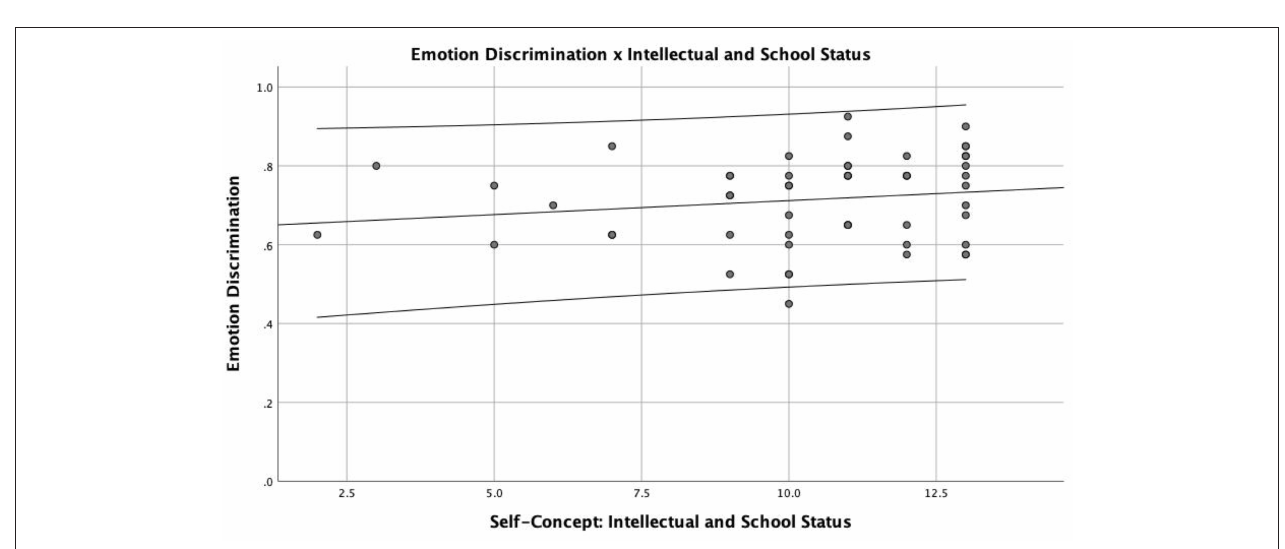
FIGURE 2 | Association between correct emotion discrimination and self-concept for intellectual and school